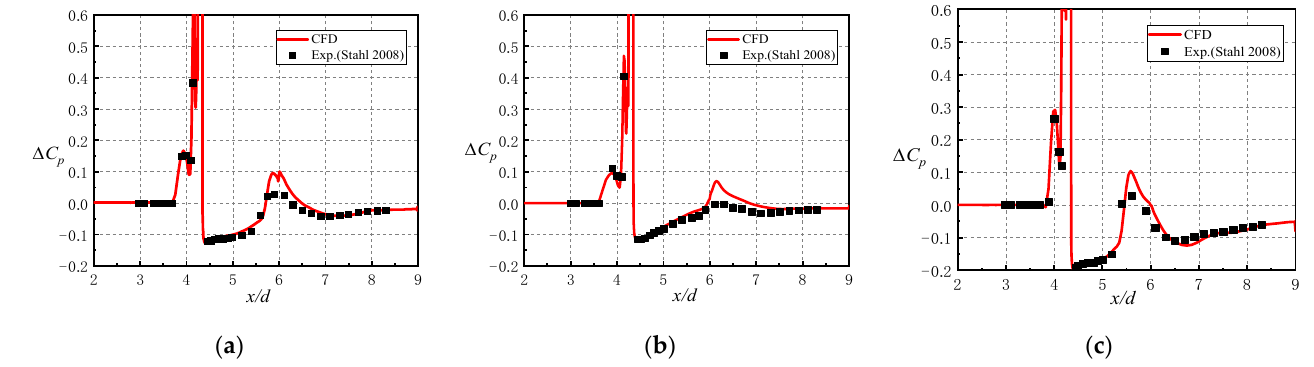
Figure 5. Comparison of the pressure coefficient obtained by numerical simulations and experimental data for different angles of attack: ( a ) α = 0 ◦ ; ( b ) α = 10 ◦ ; ( c ) α = − 10 ◦ .